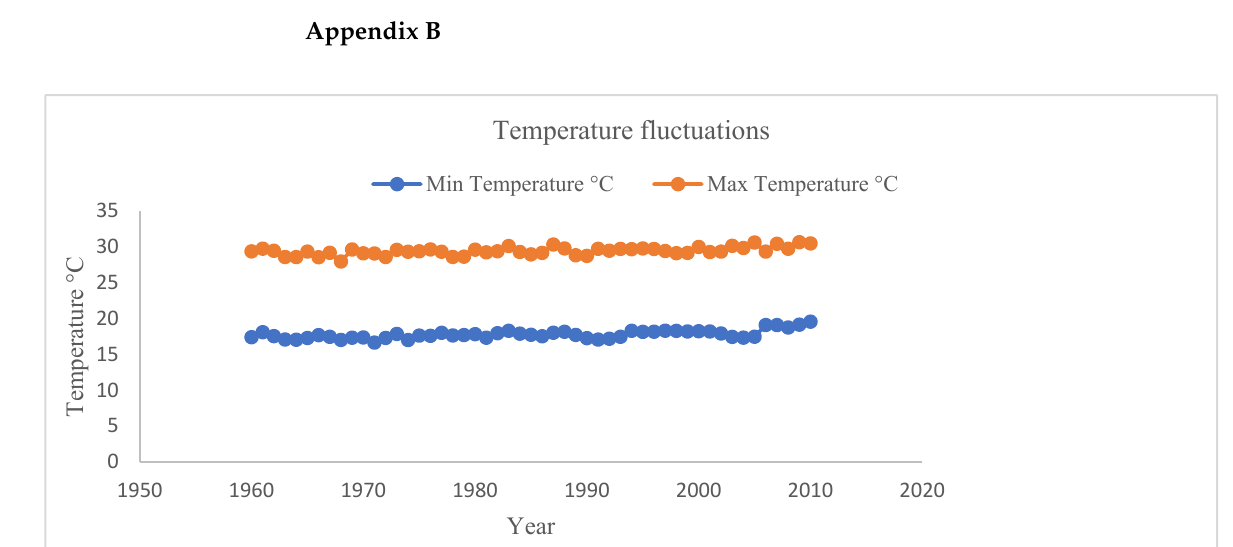
Figure A1. Changes in annual precipitation (mm) measured at Moshi Airport Moshi Municipal,